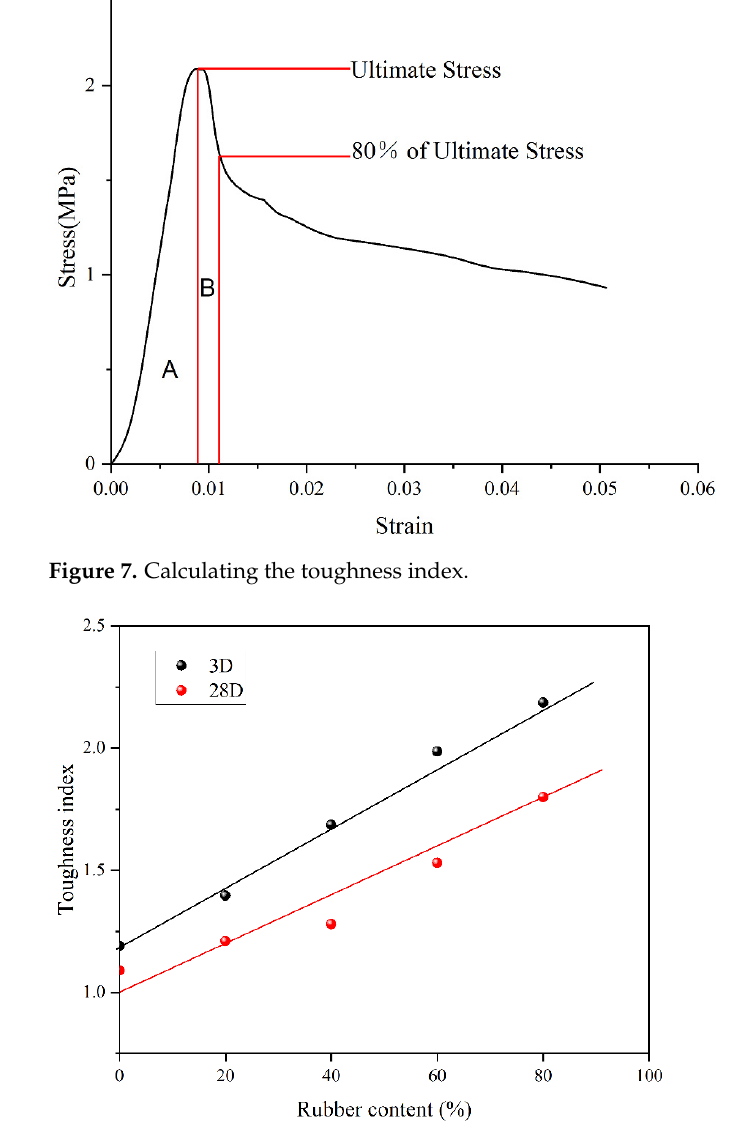
Figure 8. Toughness indices for different rubber contents without fiber.